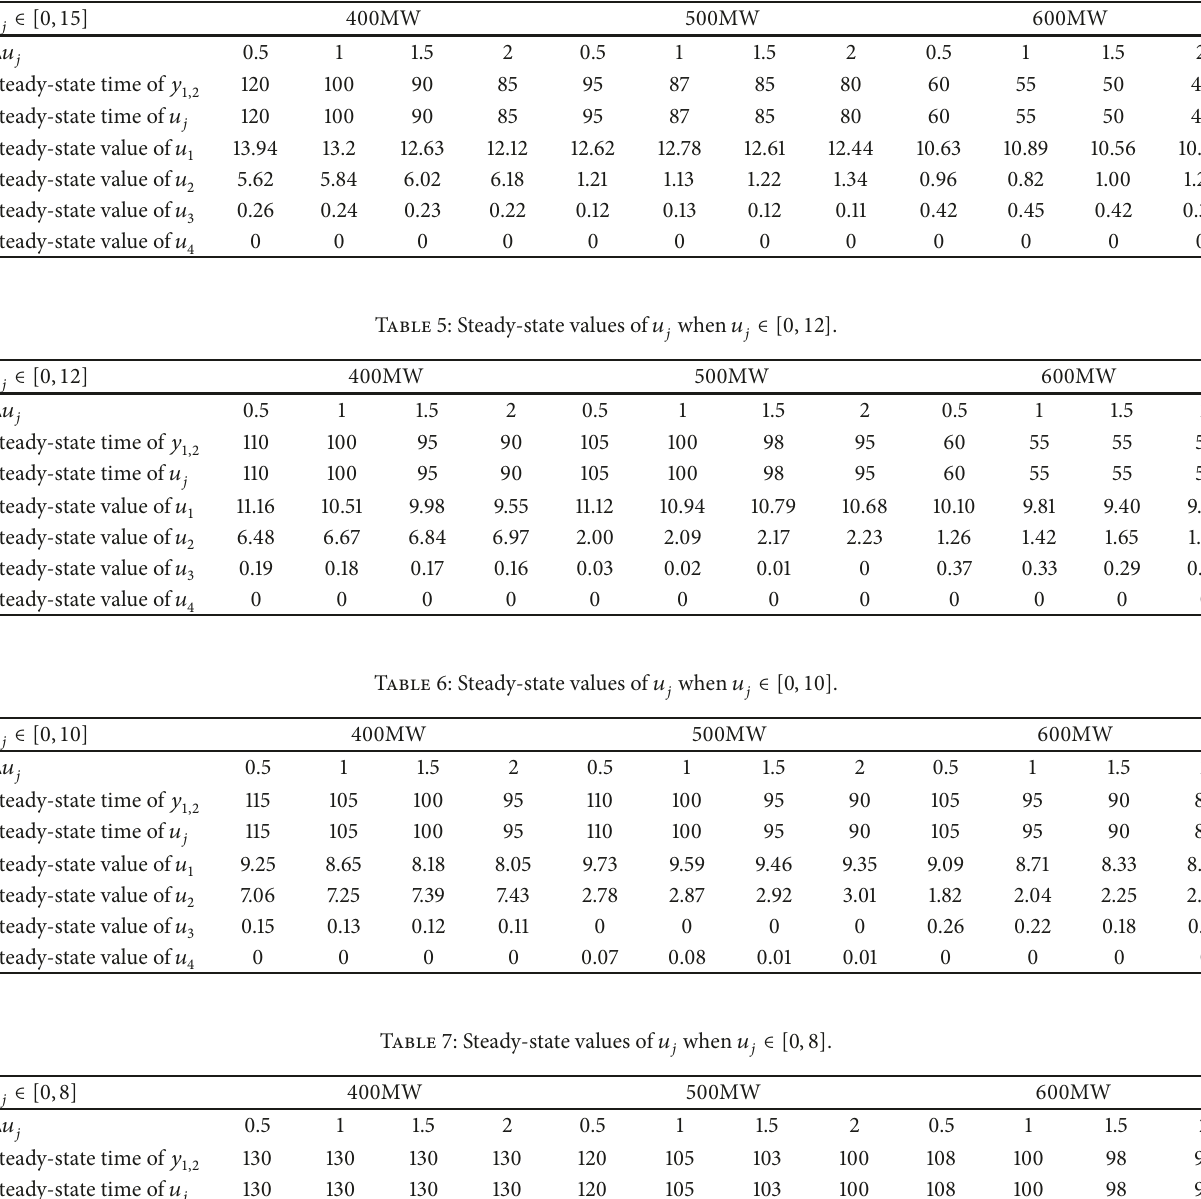
Table 4: Steady-state values of 𝑢 𝑗 when 𝑢 𝑗 ∈ [0,15] .